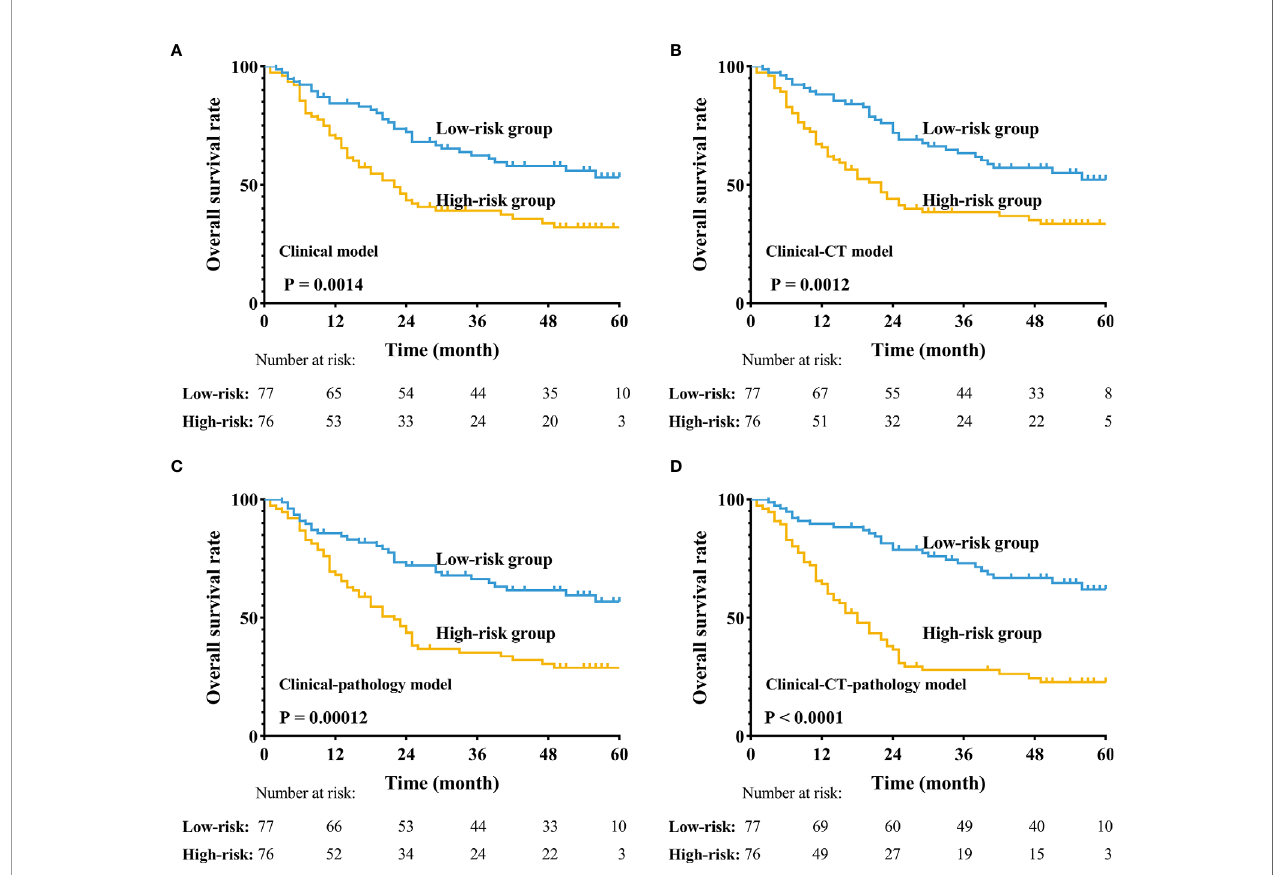
FIGURE 4 | Application of the four different prognostic models to re fi ne the assessment of risk in ESCC. (A – D) Kaplan-Meier survival estimates for a group of patients with ESCC from the whole cohorts and the subgroups predicted to have either a high or a low probability of mortality.